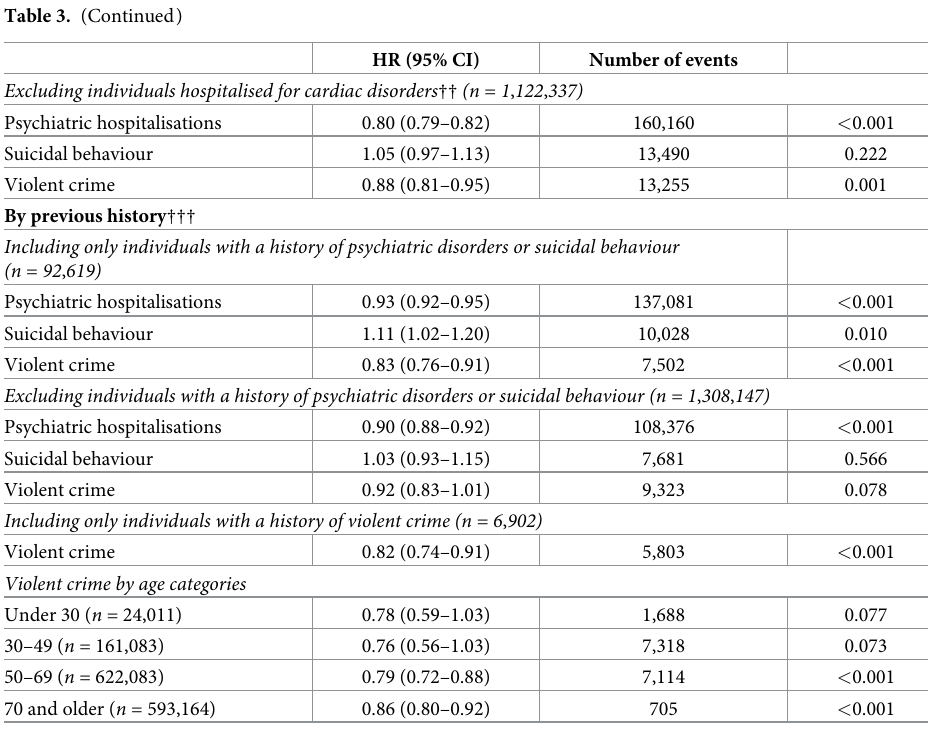
(Table 3), we carried out analyses excluding individuals prescribed psychotropic (i.e., antide- pressants or benzodiazepines) or cardiac medications (i.e., calcium channel blockers, renin- angiotensin system acting agents, or statins), and individuals with polypharmacy (i.e., 5 or more different medication classes during the same calendar year). Associations remained simi- lar to the main analyses when excluding individuals with each respective medication or polypharmacy.